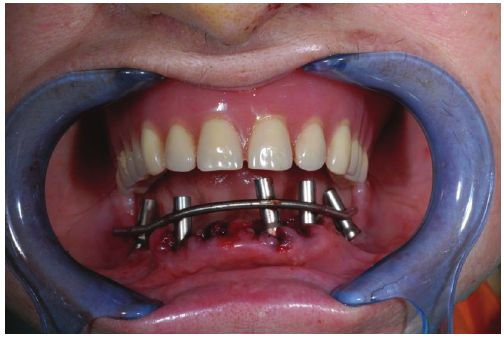
Figure 7: Titanium bar welded on abutments.